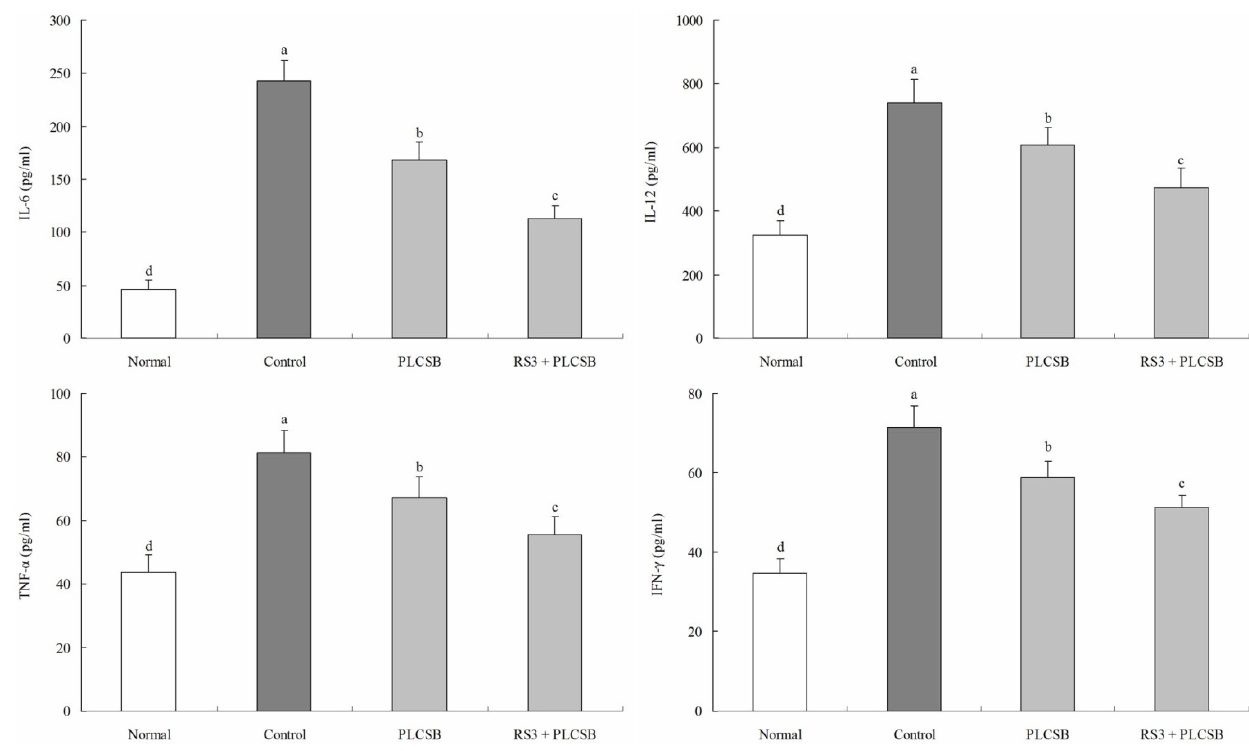
Figure 2. Serum IL-6, IL-12, TNF- α , and IFN- γ levels of mice with AOM and DSS-induced colon cancer treated with PLCSB and RS3 + PLCSB. PLCSB, polysaccharide of Larimichthys crocea swimming bladder; RS3, resistant starch 3; a–d Mean values with different letters over the bars are significantly different ( p < 0.05) according to Duncan's multiple range